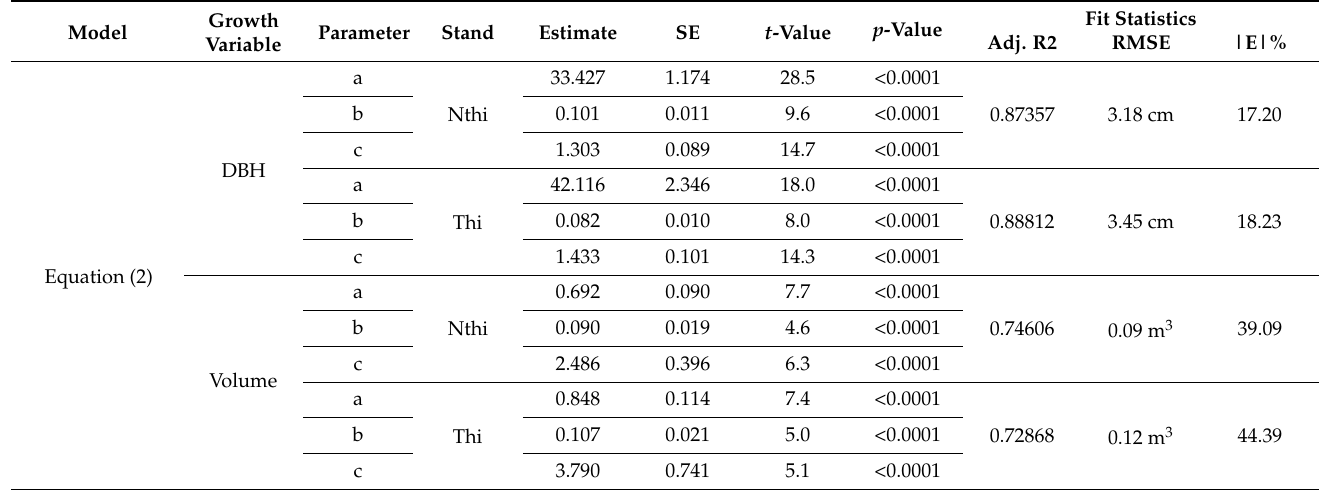
SE standard error, RMSE root mean square error, |E|% mean percentage